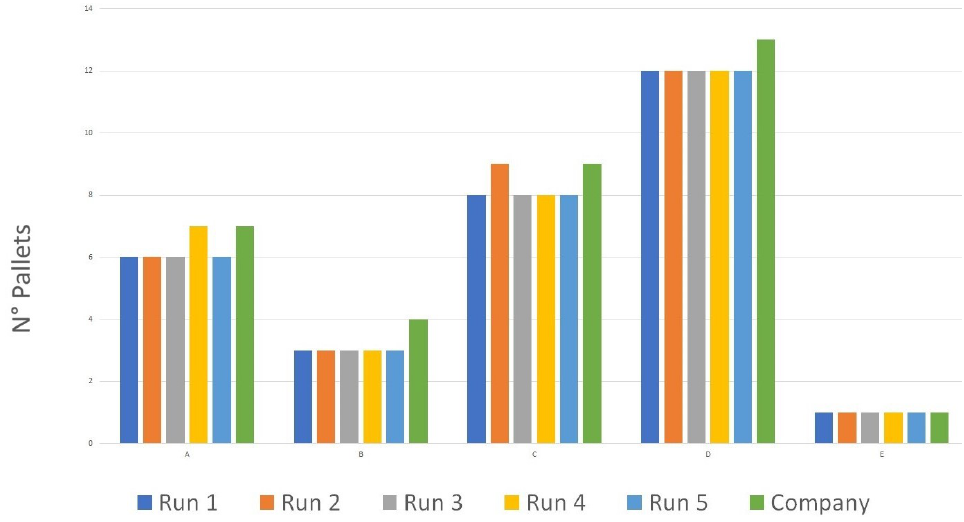
Figure 3. Pallets for every run, for every instance, with company